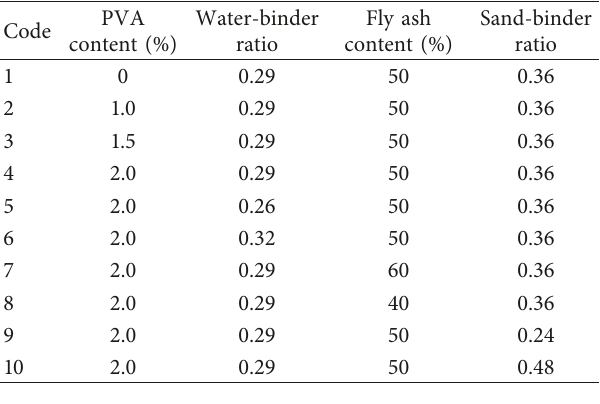
Table 2: Mix design for experimental program.